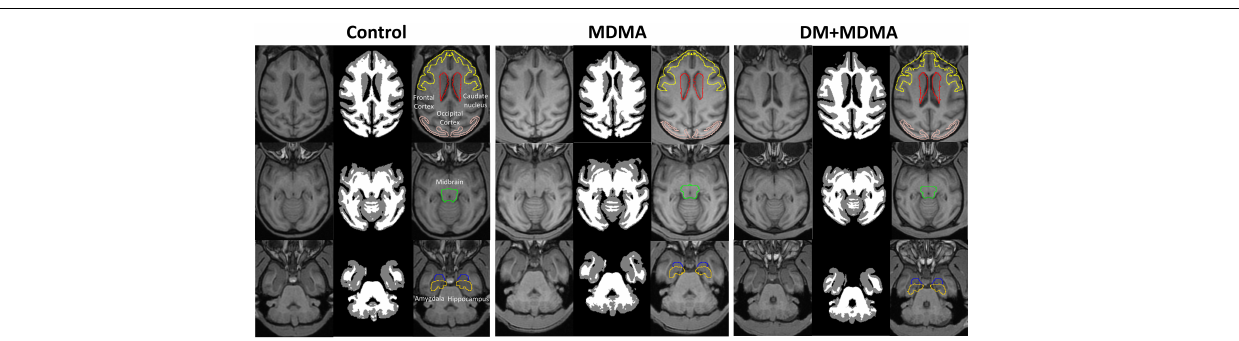
FIGURE 6 | Volumetric differences between the control (Left), MDMA (middle), and DM + MDMA (right) groups. MDMA led to higher gray matter volumes in young primates; DM + MDMA had no effect on the MDMA-induced changes in brain